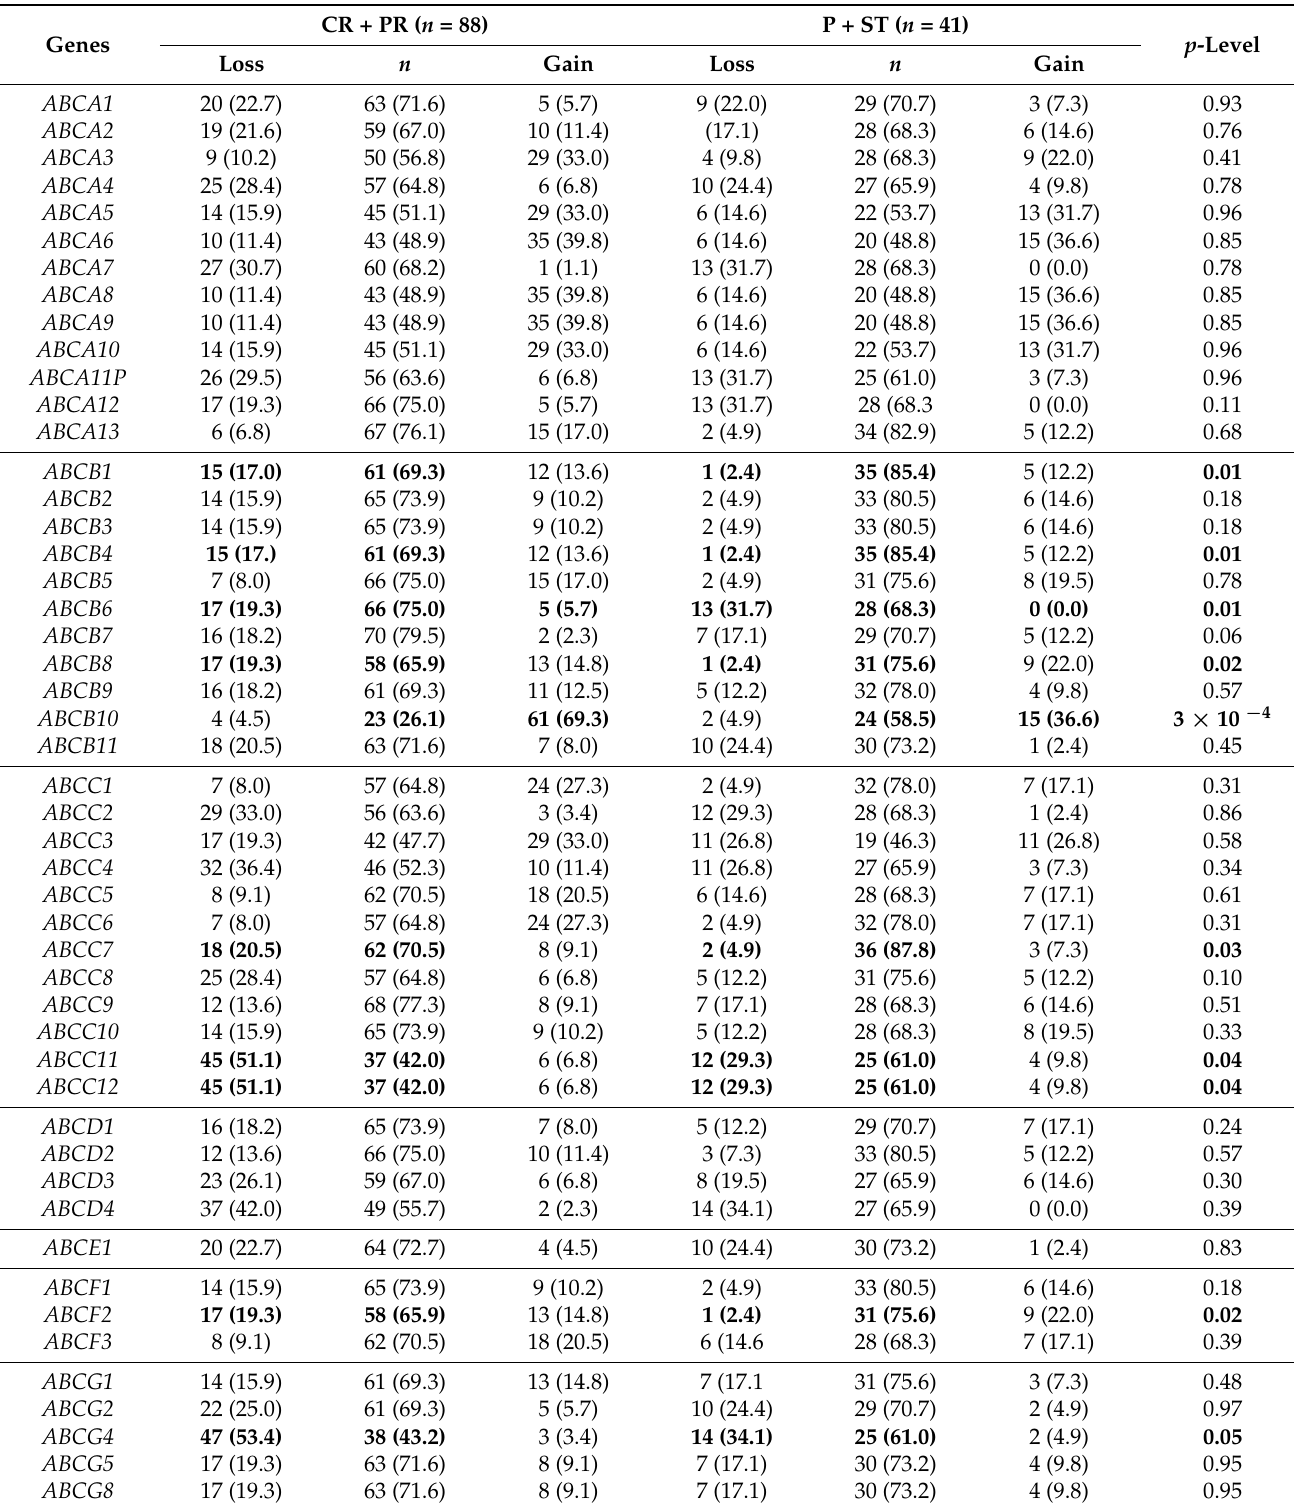
Table 2. Frequency of chromosomal aberration ABC transporter genes in breast tumours in patients with different responses to